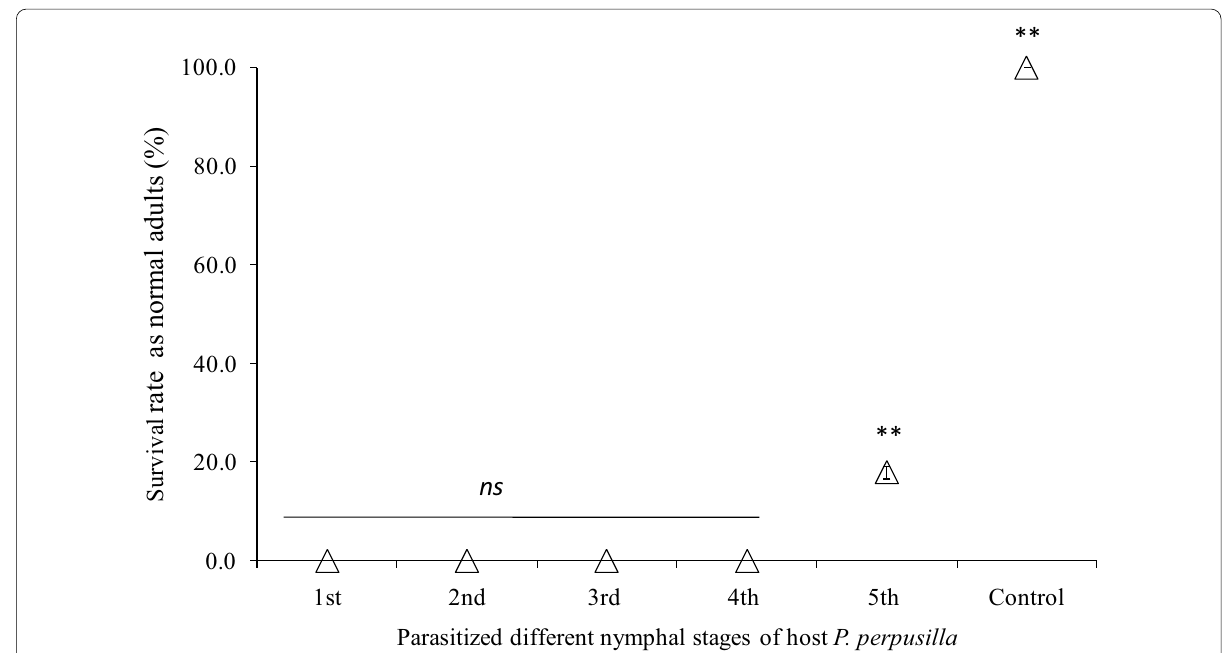
Fig. 2 Survival of host P. perpusilla as normal adults when various nymphal stages were offered to parasitoid F. melanoleuca for parasitism as against un-parasitized nymphs; “**” and “ns” within a column indicate significant difference and no difference, respectively; the results are presented as the means SEs; control represents un-parasitized nymphs ±